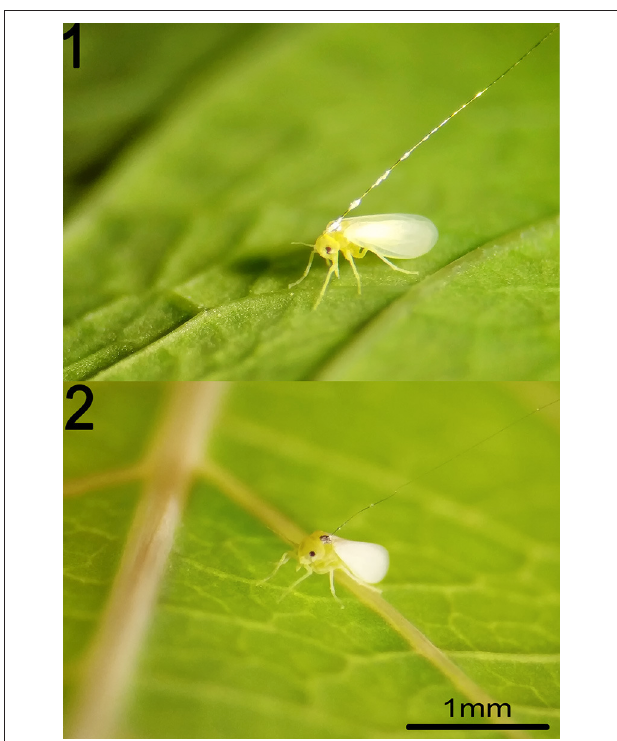
FIGURE 4 | Bemisia tabaci SSA1-SG3 on the abaxial surface of a cassava leaf wired with 12.5 µ m gold wire (1) and with 2.5 µ m platinum wire (2).